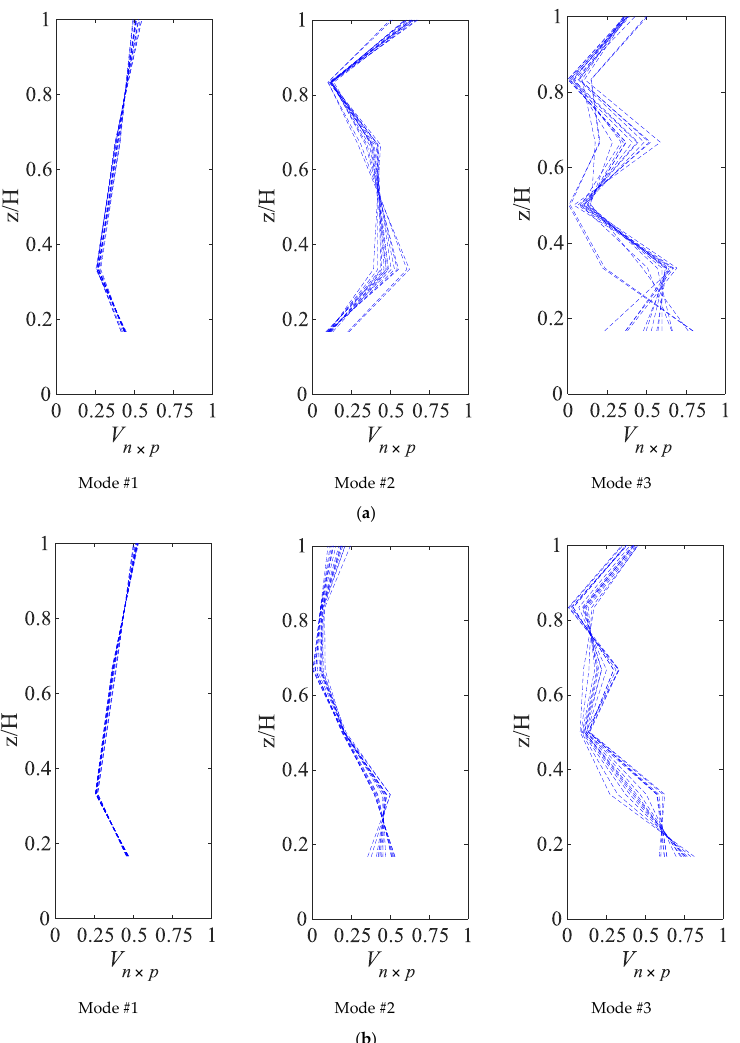
Figure 5. Eigenvectors along wind ( a ) and across wind ( b ) variability with 𝑈 = 49.0 m/s.